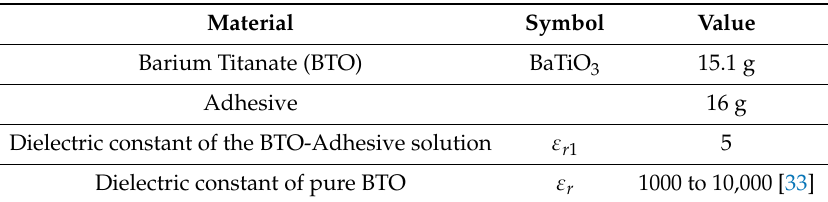
Table 3. BTO layer composition.